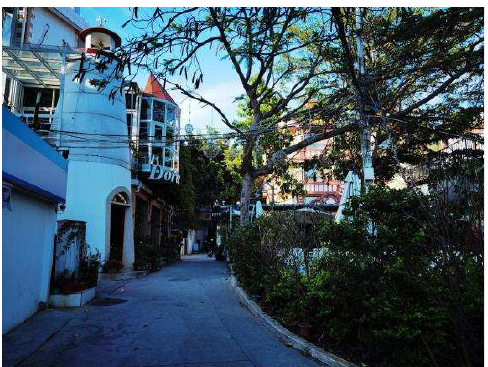
Figure 5. A seaside-style holiday hotel. Source: Taken by the authors.